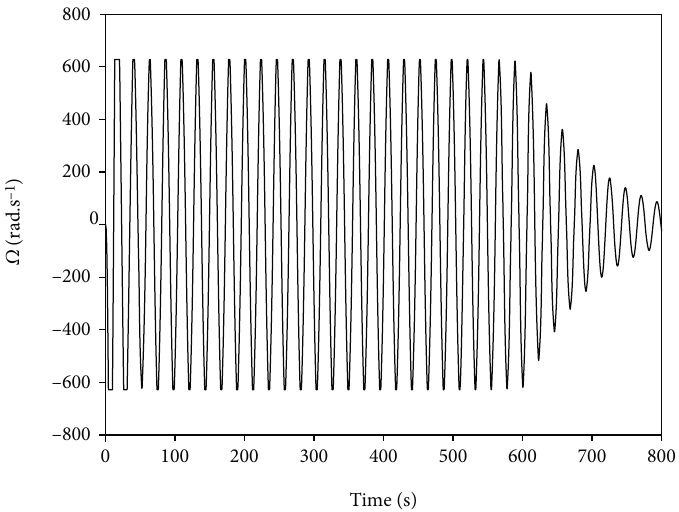
Figure 8: Rotational speed of the RW with variable-gain control.